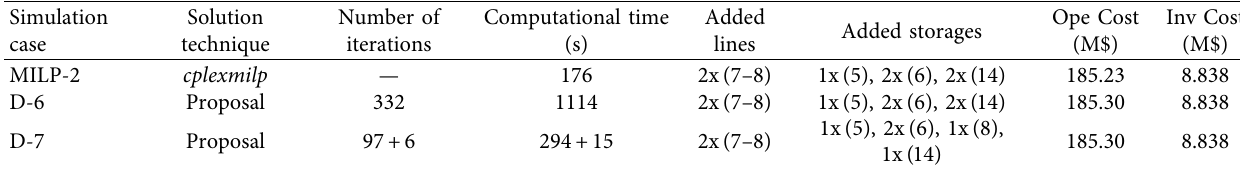
Table 3: Simulation results for 24-bus modified IEEE-RTS test